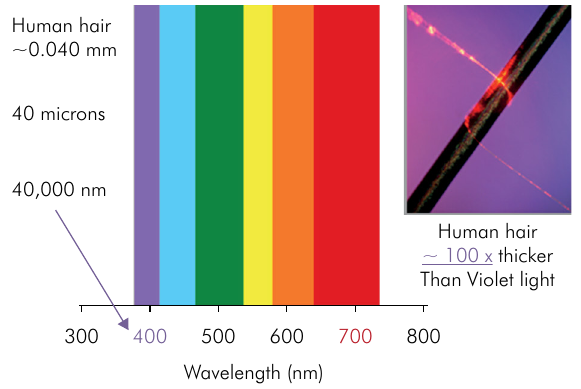
Figure 7. Correlation of wavelength (in nanometers) and human perception of color, as well as perspective of the physical wavelength of violet